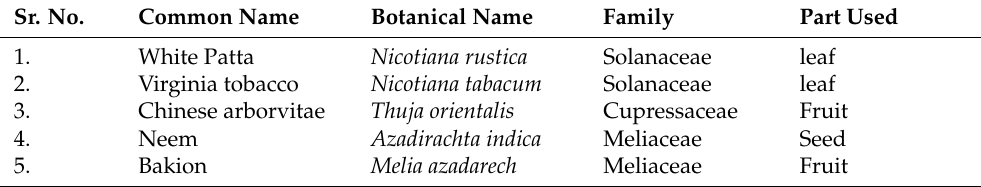
Table 1. List of plant species and plant parts tested against C. maculatus during 2021. Sr.